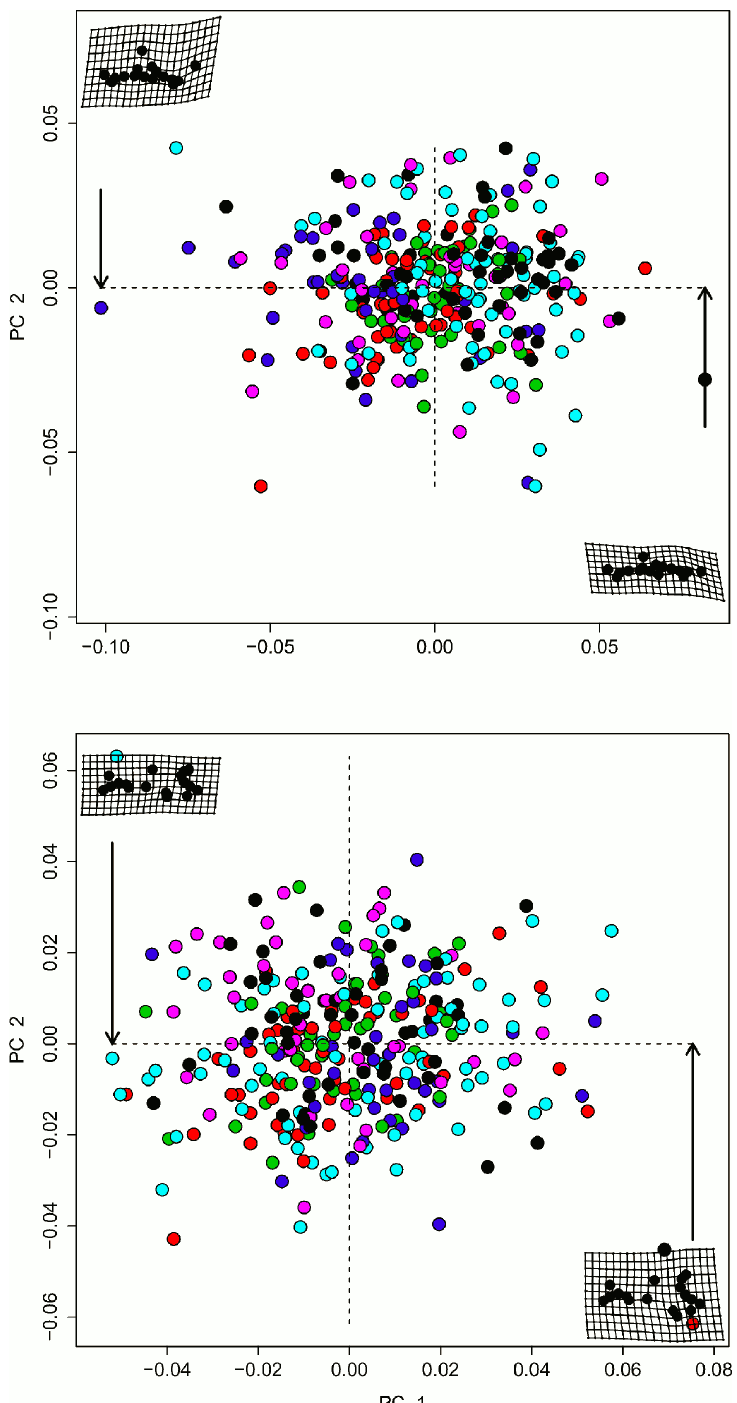
Fig 3. Tangent space for upper jaws (top) and mandibles (bottom). PC axes 1 and 2 explain the maximum amount of variation in the data (upper jaws: 27 and 13%, mandibles: 25 and 13%). The thin plate spline deformation grids in each corner represent the largest difference among all specimens, by indicating what each structure looks like at the ends of PC axis 1 relative to a specimen at the origin (0,0), as described in the methods. Colors are locations as follows: Black: EMND; Red: IOWA; Green: MAKA; Blue: NILL; White: OTKA; Grey: WAMN. Sample sizes and abbreviations are as in Table 1.